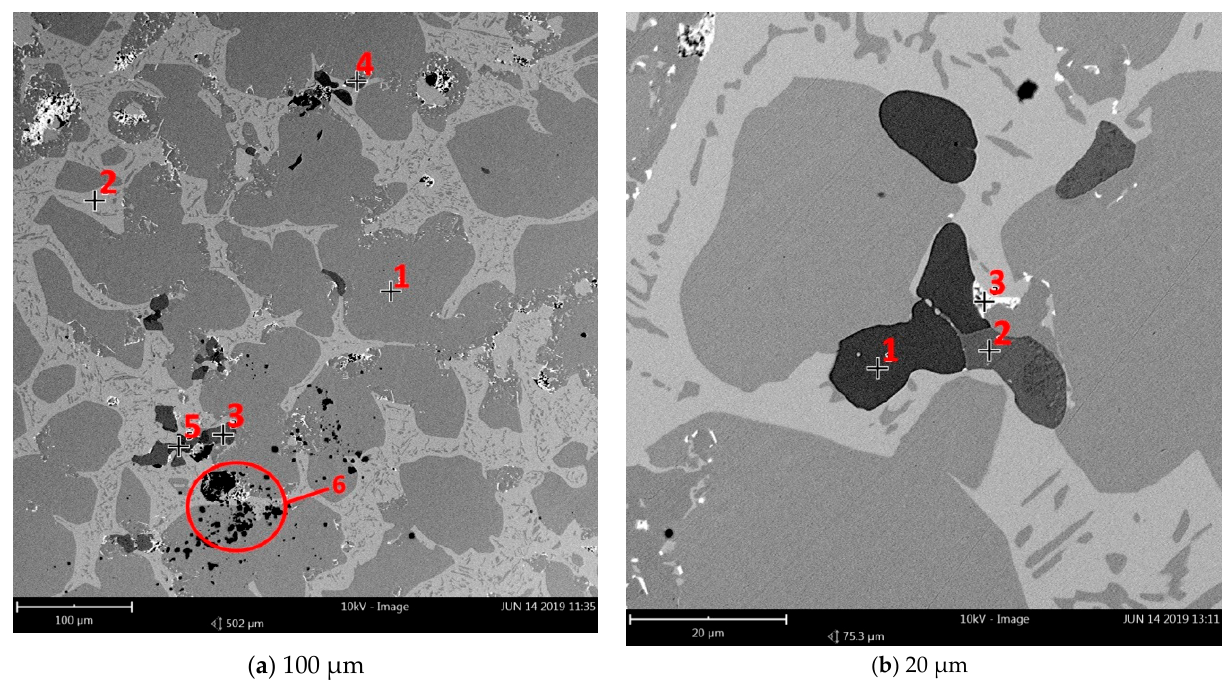
Figure 3. Location of the measurement points for scanning microscope examination with visible impurities and inclusions.